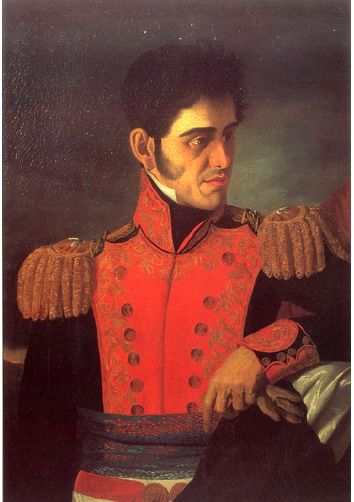
Figure 3. Fierce and Flashy: A Painting of Antonio López de Santa Anna, courtesy of Museo Nacional de Historia, México.